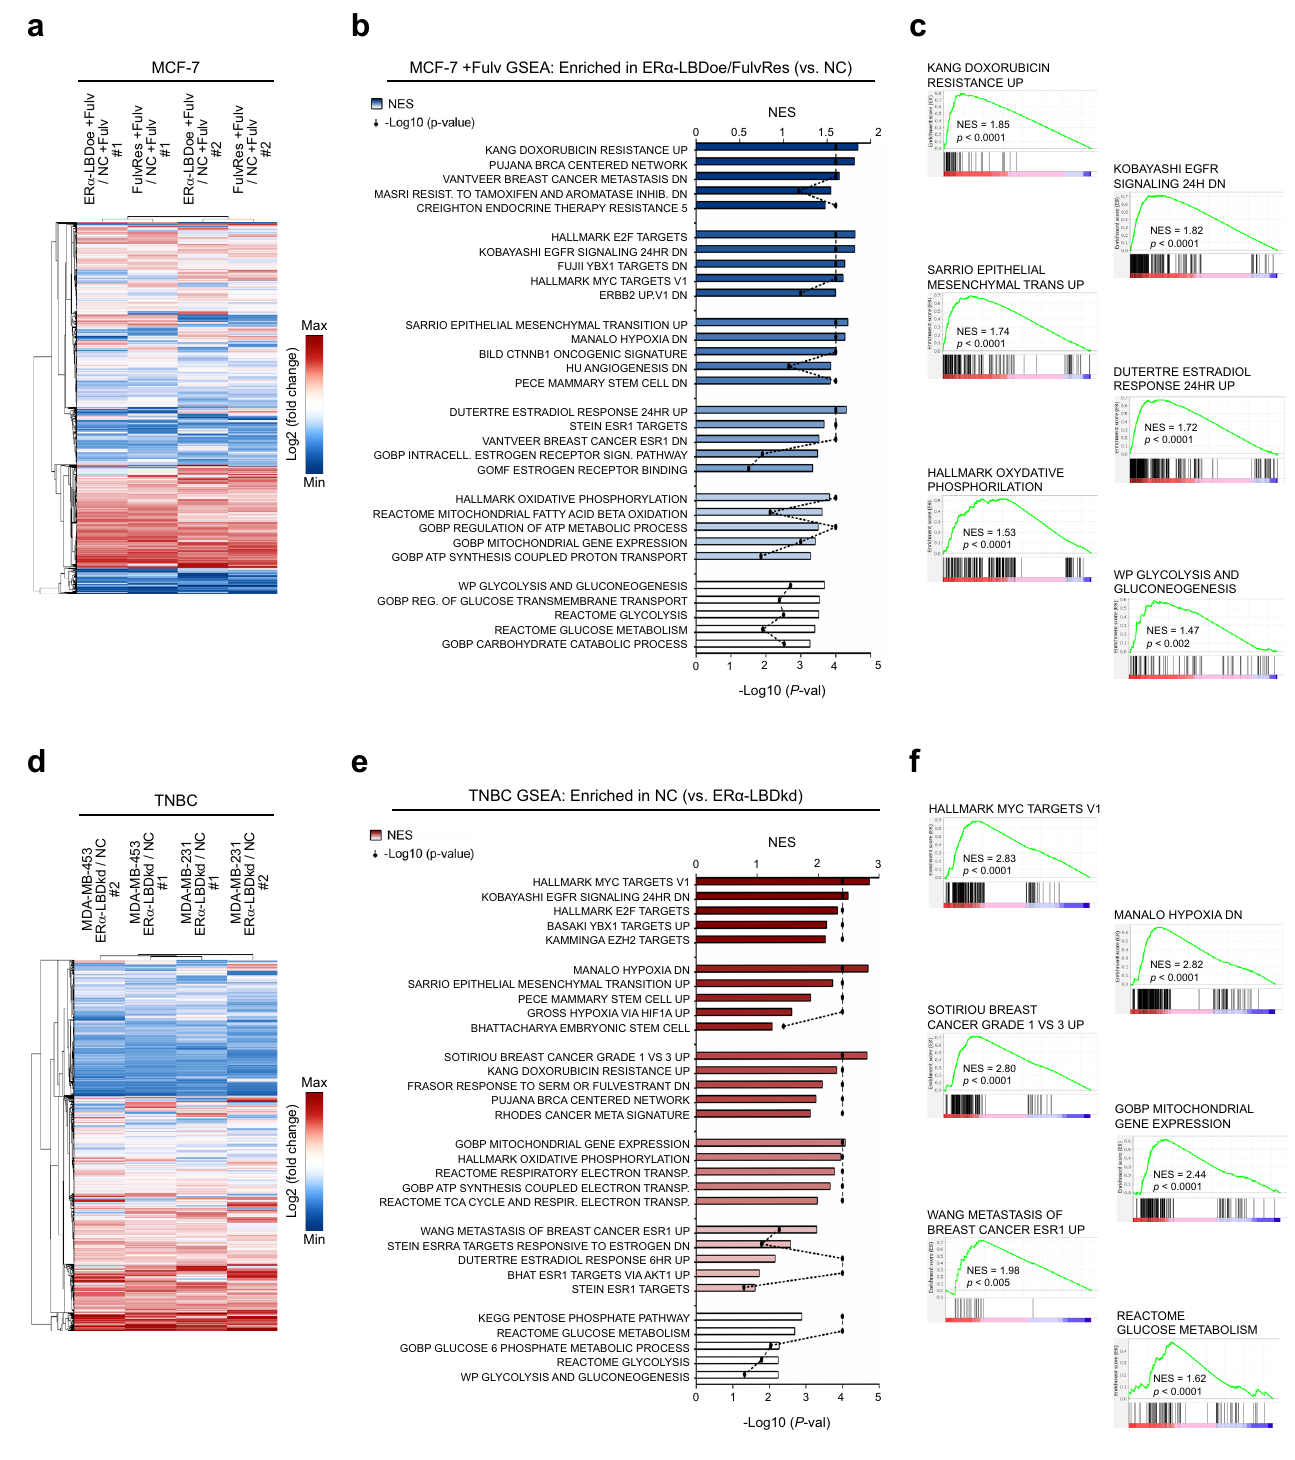
models compared to MCF-7 control cells (NC). RNA-seq analysis led to the identi fi cation of ~17 K differentially regulated genes (Fig. 7a and Supplementary Data 5). Gene set enrichment analysis (GSEA) was performed on these same samples using speci fi c gene set collections related to breast cancer, cell proliferation, and cell metabolism (Supplementary Data 6). Interestingly, gene